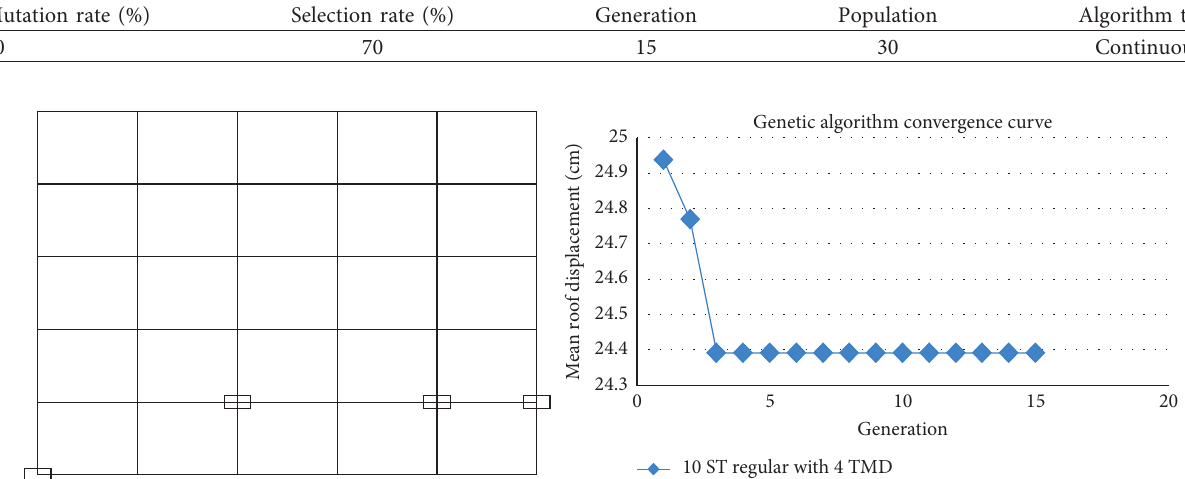
Figure 16: Convergence diagram of the ten-story model with 4 dampers in genetic algorithm (right) and damper optimal positions (left).